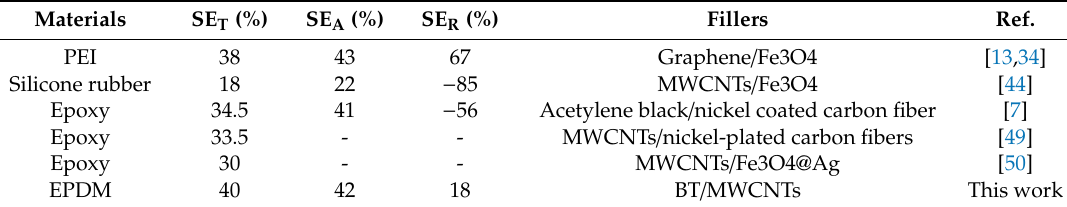
Figure 7. ( a ) and ( b ) SE T and contribution of SE A and SE R of BT / MWCNTs and MWCNTs nanocomposite foams at 10 GHz, respectively; ( c ) EMI SE of the hybrid sample with 10 phr MWCNTs before and after repeated bending. Table 2. Comparison of the improvement percentages of the EMI SE in hybrid nanocomposite foams in the X-band.